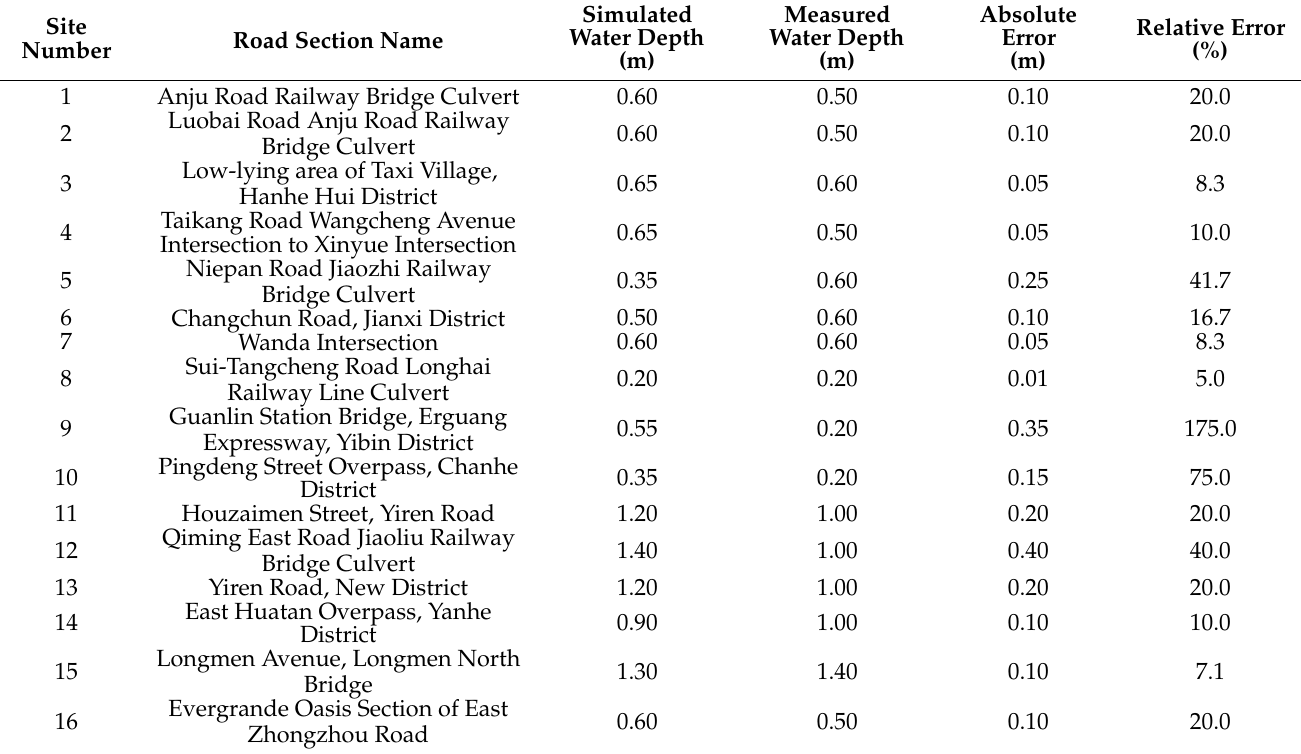
Table 2. Table of simulation results of flooding depth of water accumulation point in storm 1.